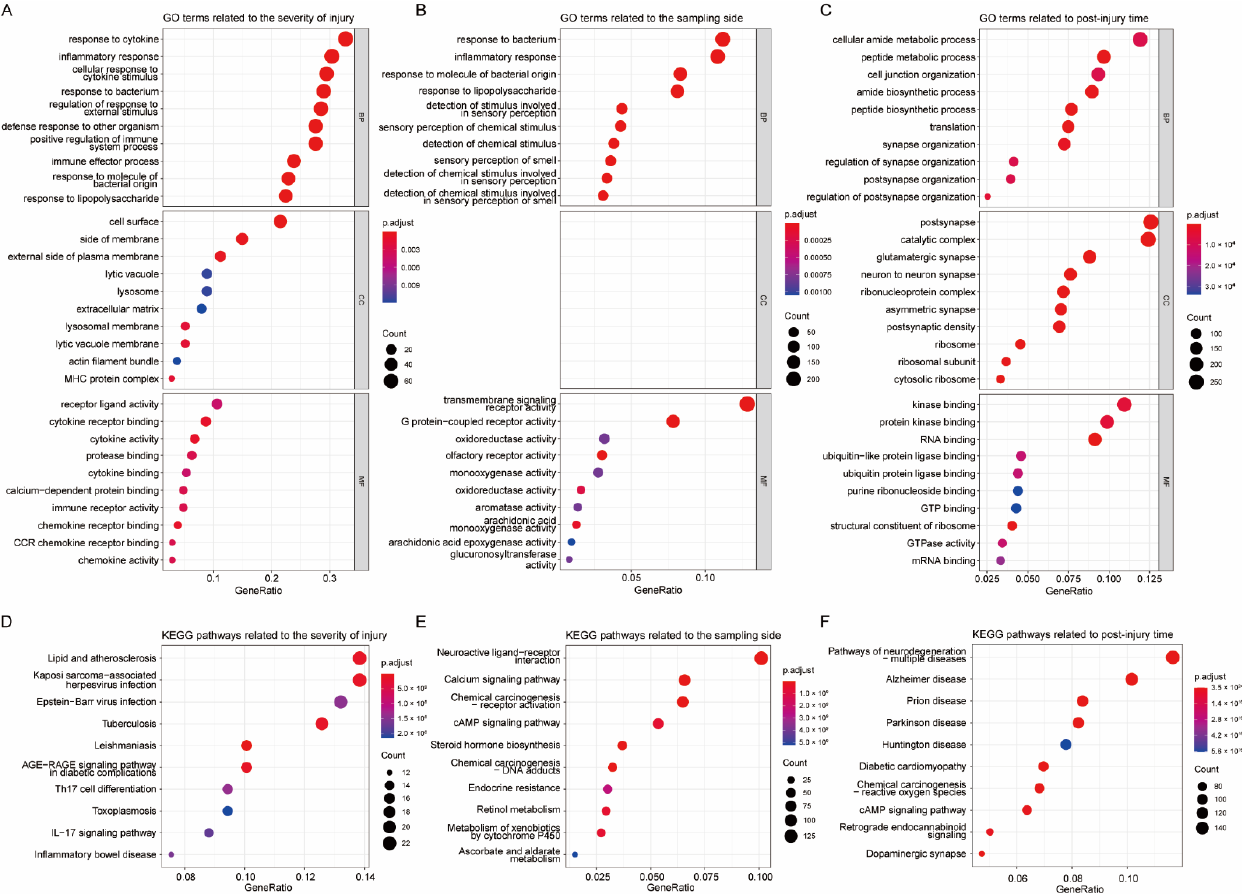
Figure 2. KEGG and GO enrichment analysis of the genes in sample-traits-related modules. ( A – C ) Dot plots illustrating GO terms enriched in modules related to the severity of injury ( A ), sampling side ( B ), or postinjury time ( C ); ( D – F ) dot plots showing KEGG pathways enriched in modules related to severity ( D ), side ( E ), and time ( F ). BP—biological processes, CC—cellular components, MF—molecular functions. Note: No term was enriched for CC in ( B ).